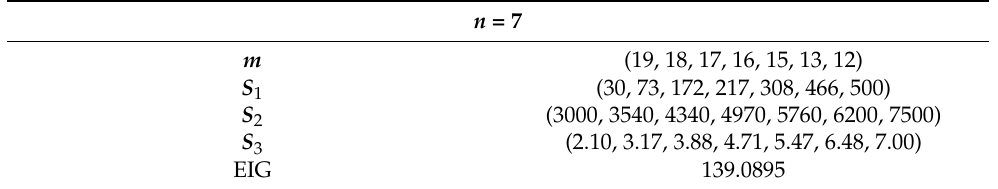
Table 8. The optimal test plan of pre-test optimization( n = 7).